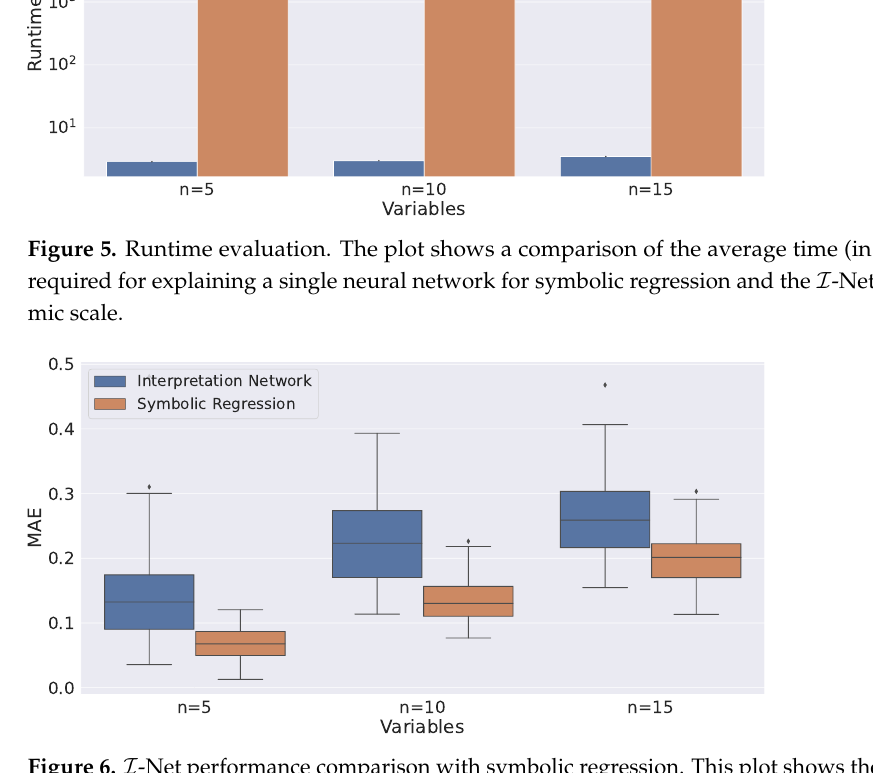
Figure 6. I -Net performance comparison with symbolic regression. This plot shows the performance in terms of the MAE for all evaluated approaches for three different dataset